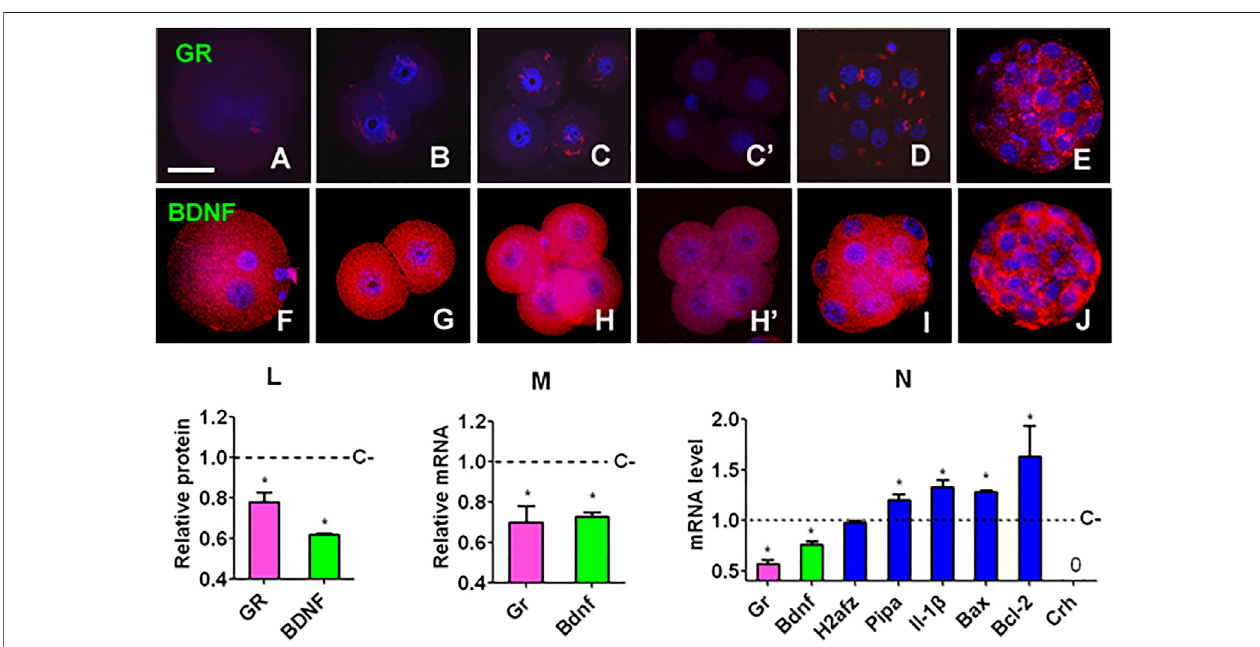
FIGURE 2 | Gene expression in mouse embryos following culture with or without corticosterone. (A,F) , (B,G) , (C,H) , (D,I) and (E,J) Expression of GR/BDNF proteininzygote,2-cell,4-cell,morulaandblastocystembryos,respectively,afterculturewithoutcorticosterone. (C ’ ,H ’ ) ExpressionofGRandBDNF,respectively,in4- cell embryos cultured with corticosterone. The micrographs are merged images from laser confocal microscopy with GR/BDNF and DNA pseudo colored red and blue, respectively. The bar is 30 µm. (L,M) Relative levels of protein (immuno fl uorescence intensity) and mRNA (RT-PCR) of GR and BDNF, respectively, in 4-cell embryosculturedwith(+)orwithout( − )corticosterone(C).Forimmuno fl uorescencemicroscopy,eachtreatmentwasrepeatedthreetimesandeachreplicatecontained 10 – 15blastomeresrandomlyselectedfrom15to20pooledembryos,forRT-PCR,eachtreatmentwasrepeatedthreetimeswitheachreplicatecontaining60embryos. (N) Relative levels of different mRNAs in blastocysts after C+ or C − culture. Each treatment was repeated three times with each replicate containing 50 blastocysts.